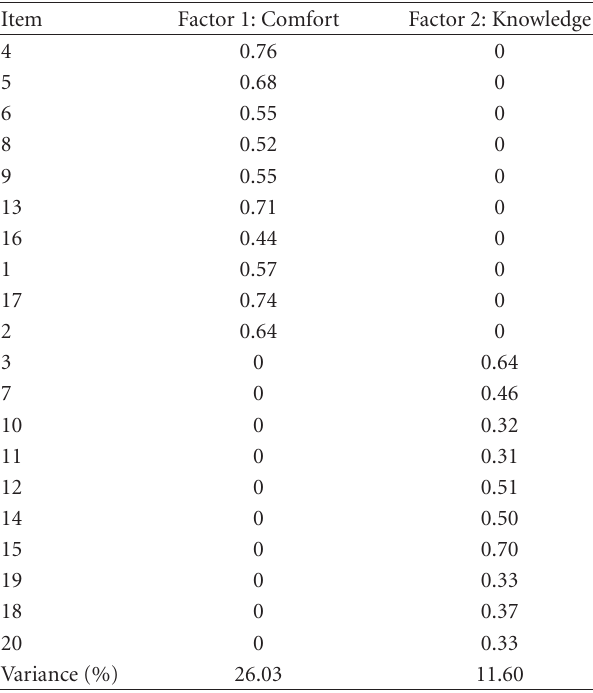
Table 4: Confirmatory factor analysis of the dementia attitudes scale